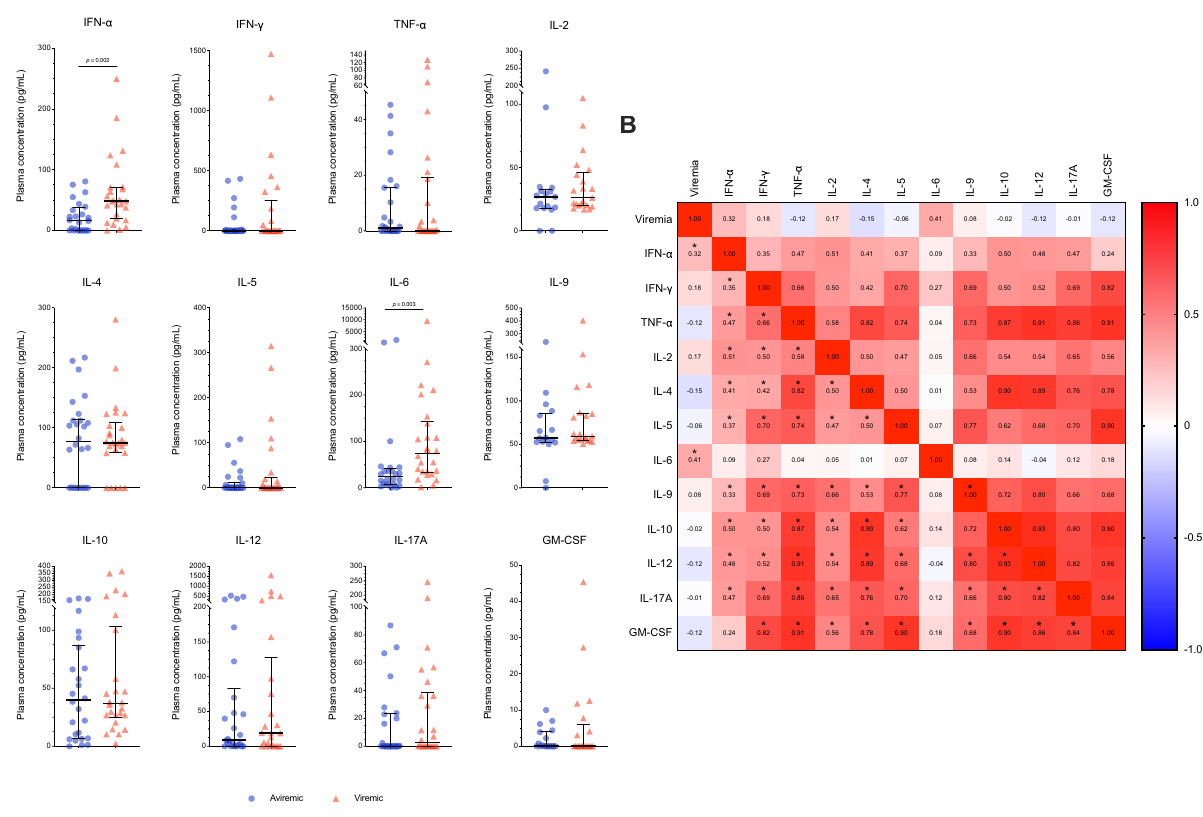
Figure 1. Plasmatic cytokines in COVID-19 patients according to SARS-CoV-2 viremia. ( A ) Plasmatic cytokines in aviremic and viremic COVID-19 patients. IFN-α (n = 24 and n = 26), IFN-γ (n = 26 and n = 25), IL-2 (n = 17 and n = 21), IL-4 (n = 26 and n = 26), IL-5 (n = 26 and n = 26), IL-6 (n = 24 and n = 26), IL-9 (n = 17 and n = 21), IL-10 (n = 26 and n = 26), IL-12p70 (n = 26 and n = 25), IL-17A (n = 25 and n = 26), TNF- α (n = 26 and n = 26), GM-CSF (n = 17 and n = 21). ( B ) Heatmap of correlations between SARS-CoV-2 viremia and plasmatic cytokines. Median and interquartile range (IQR) are shown for each group of patients. Mann–Whitney U test and Spearman’s correlation test, *statistical significance at p-value <